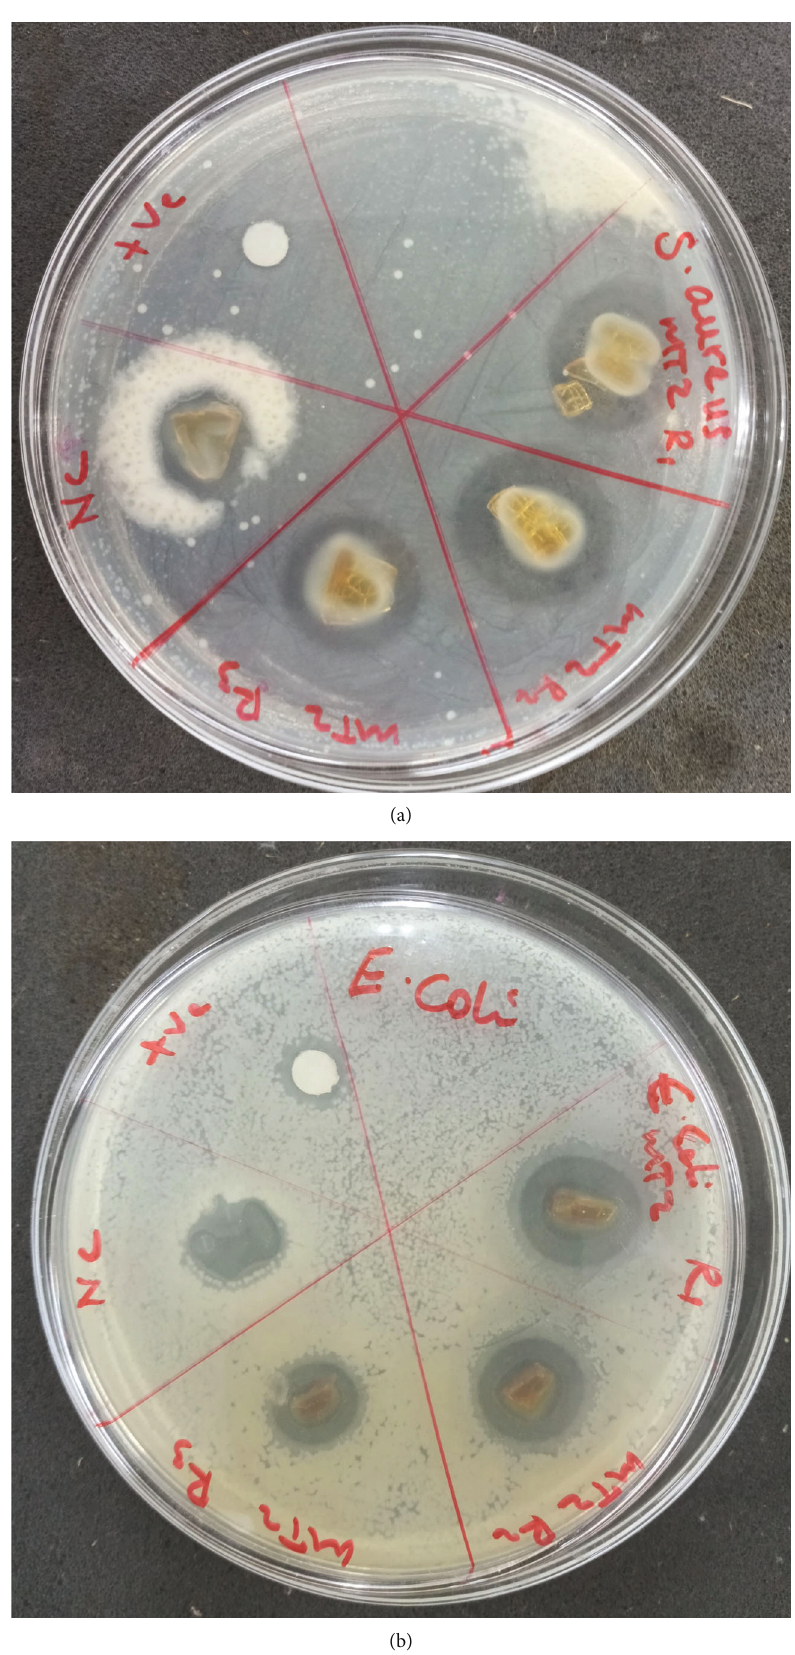
Figure 11: Disc di ff usion assays showing zone of inhibition exhibited by unloaded H2-G3 (NC), MTZ-H2-G3, and pure metronidazole (pc) against (a) Staphylococcus aureus and (b) Escherichia